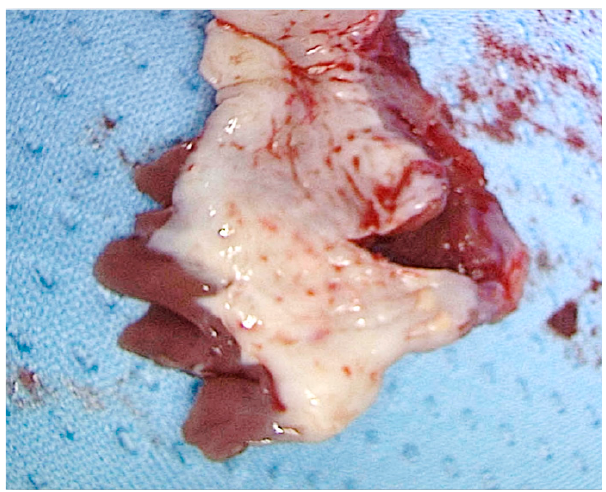
Figure 3. Specimen of interventricular septum showing endocardial fibrosis secondary to trauma caused by systolic anterior motion of the anterior leaflet of the mitral valve.